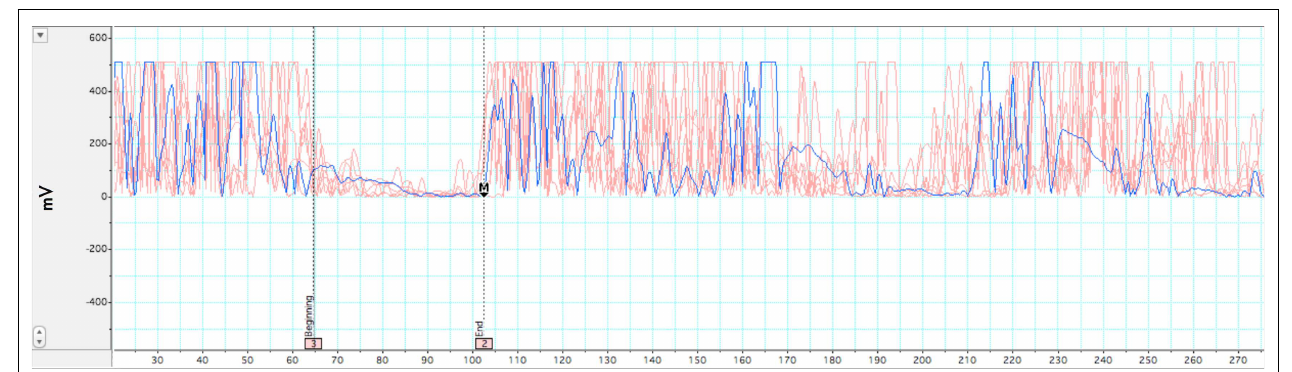
depression for the iSP. A pre-stimulus acquisition of 20ms was acquired for baseline comparison. Motor evoked potential and subsequent silent period occurs at ∼ 38ms. iSP duration for this participant was